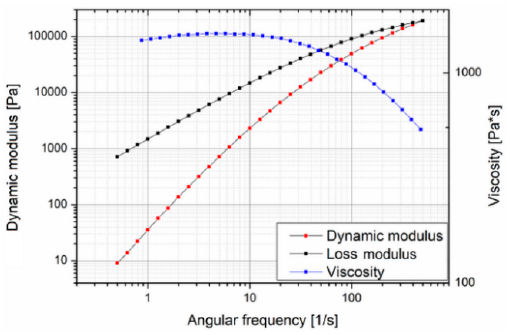
Figure 3. Rheological behavior of Purasorb PDLG 5010 at 160 ° C.